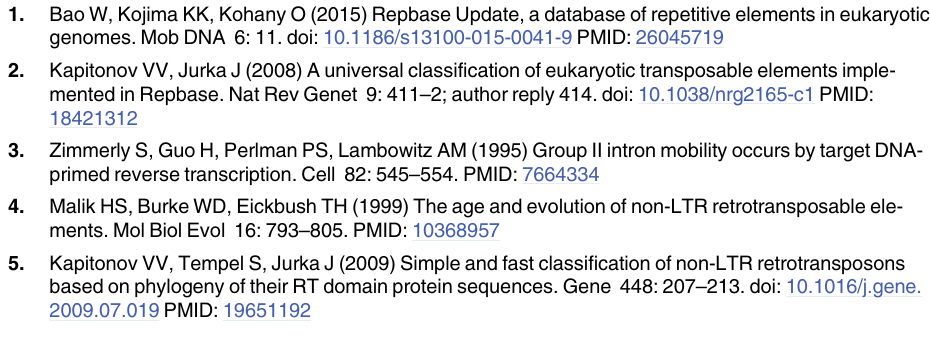
S6 Fig. Target sequences of NeSL -related non-LTR retrotransposons. Retrotransposon sequences are in lowercase while flanking sequences are in uppercase. Sequences similar to tar- get sequences are in red. S1 Table. Utopia transposons used in this study. S2 Table. All RT-coding sequences of Utopia elements in P . infestans . S3 Table. All RT-coding sequences of Utopia elements in P . sojae . S4 Table. All RT-coding sequences of Utopia elements in P . ramorum